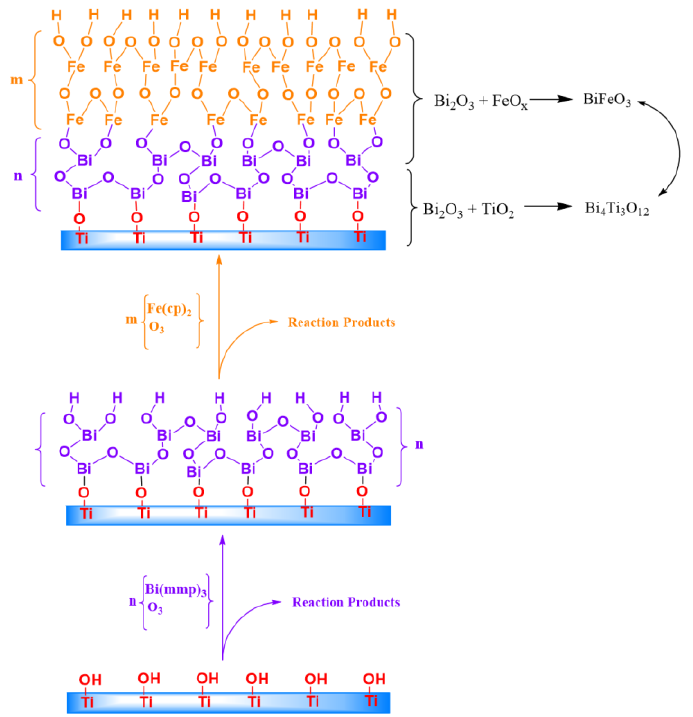
Figure 1. Schematic process of atomic layer deposition (ALD) Aurivillius phase formation.